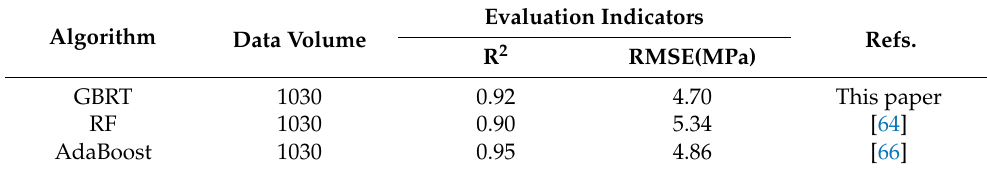
Table 8. Comparison with other ensemble learning algorithm models with the same dataset.